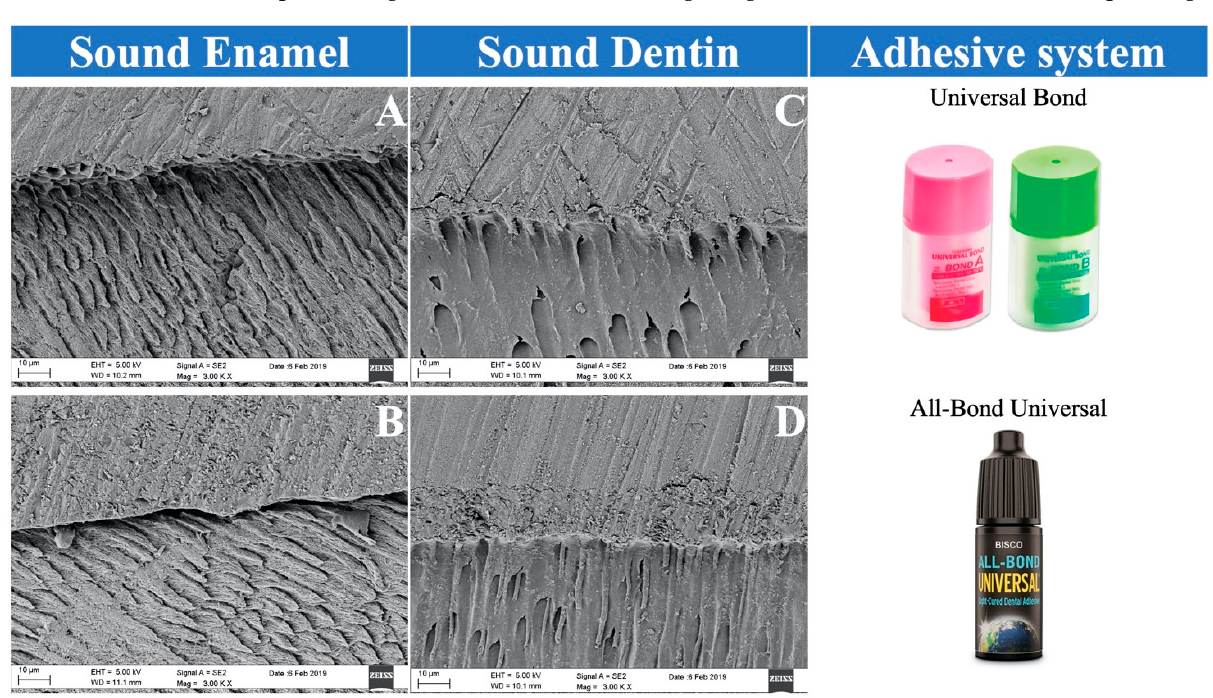
Figure 1. SEM images of interfacial bonding layer for universal adhesives on sound enamel ( A , B ) and sound dentin ( C , D ). Images ( A , B ): composite restoration (upper part) and sound enamel (lower part). Images ( C , D ): composite restoration (upper part) and sound dentin (lower part).